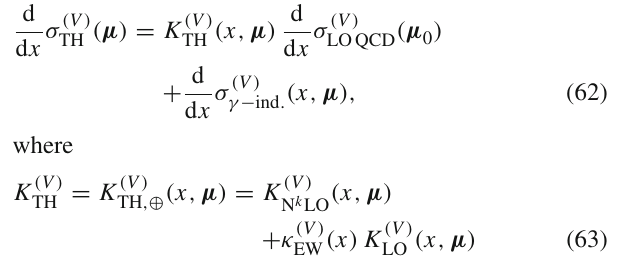
Fig. 14 Relative LUXqed_plus_PDF4LHC15_nnlo_100 PDF uncertainties on the nominal p T distributions for the different pp → V + jet processes at 13TeV evaluated to NLO QCD are shown on the left. Corresponding PDF uncertainties for ratios of V + jet distributions